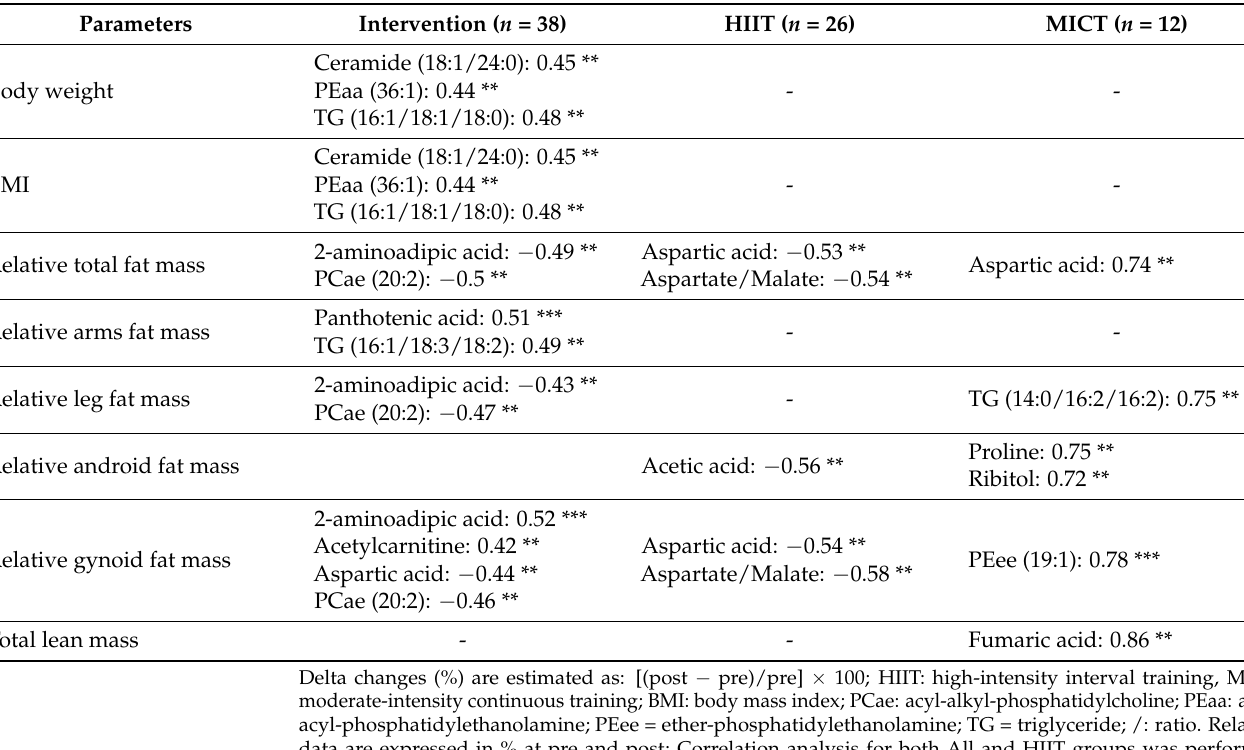
Table 5. Significant correlations between body composition parameters delta changes and significant metabolites delta changes.